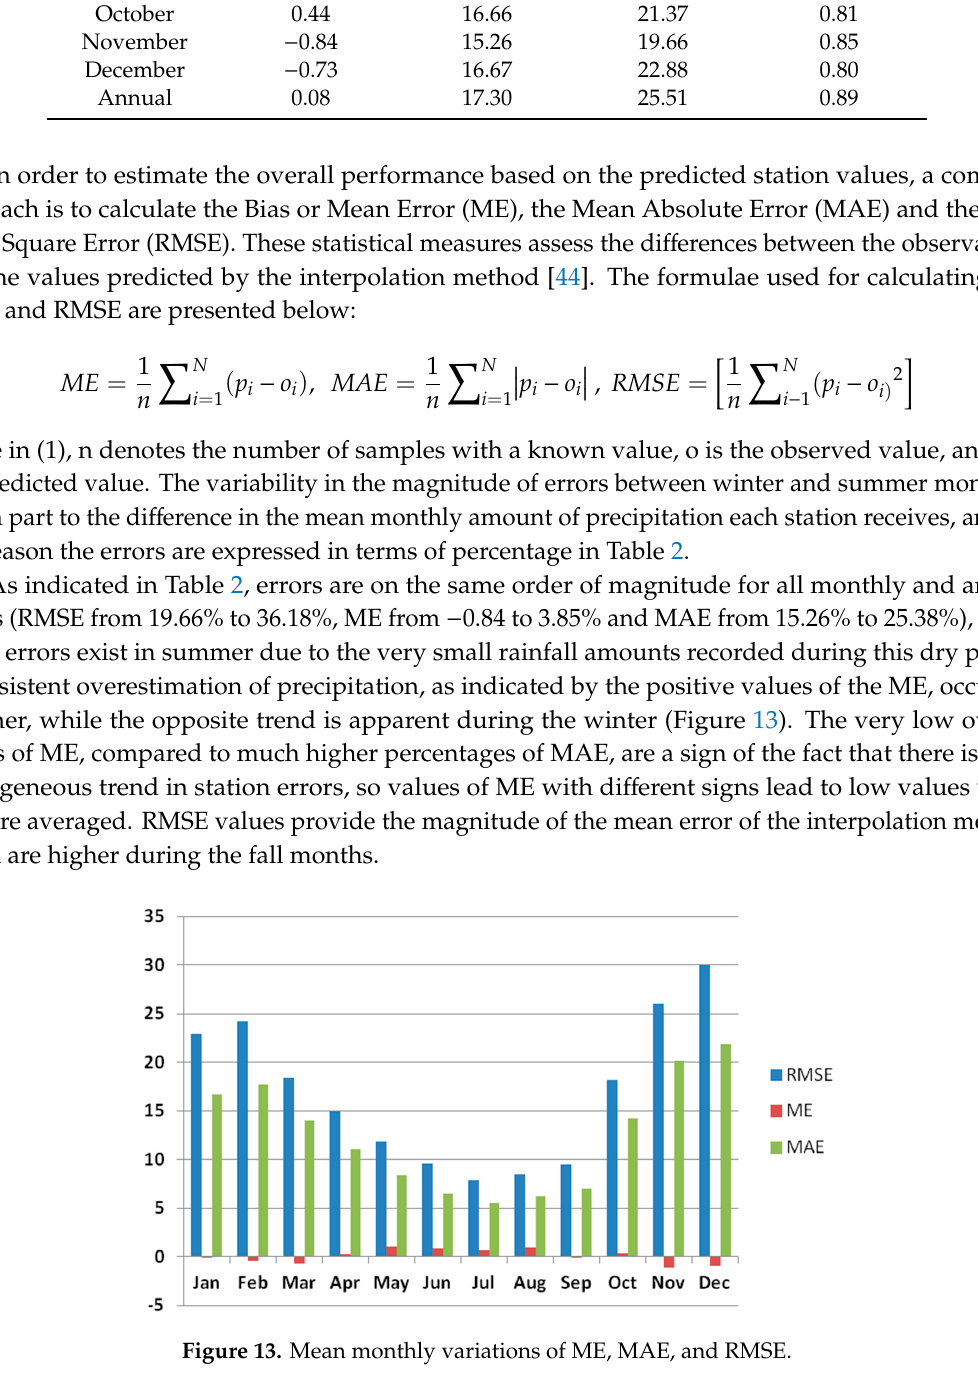
Figure 13. Mean monthly variations of ME, MAE, and RMSE.